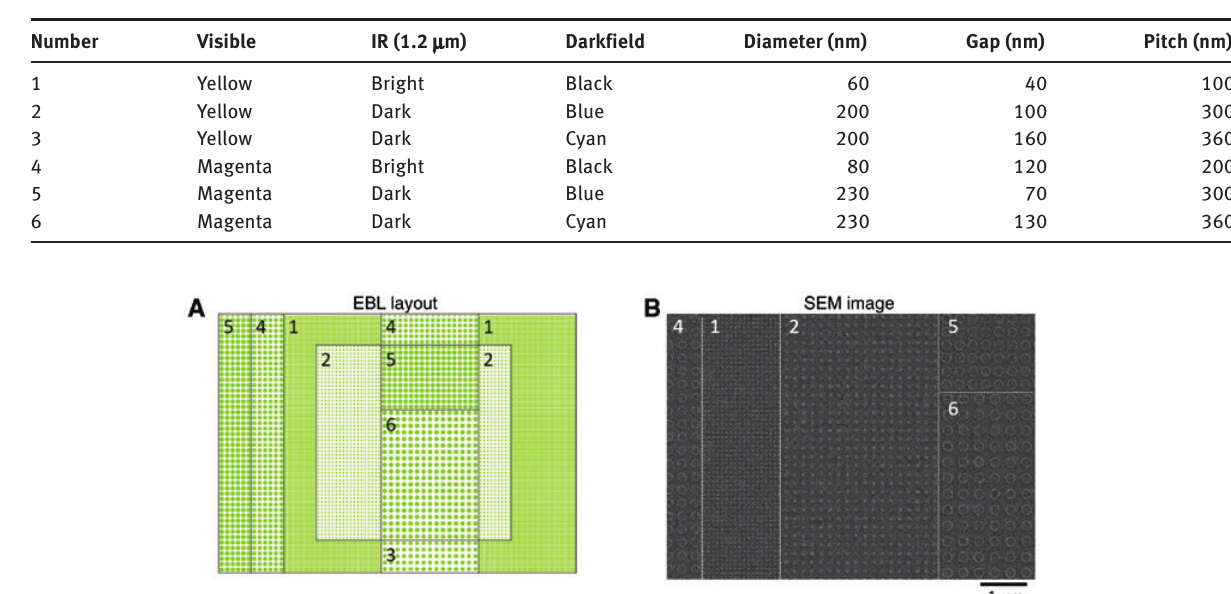
Table 2: Physical parameters of disks used to make micro-tag.